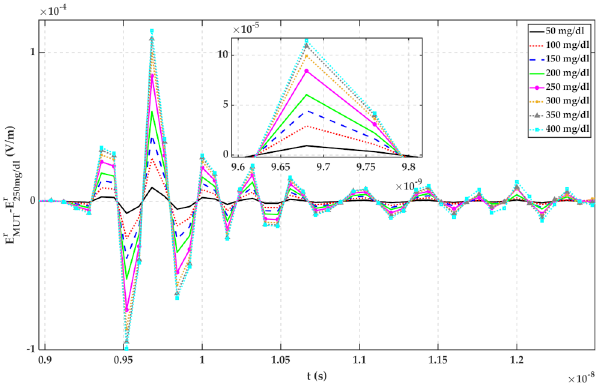
Figure 10. Reflected signal differences of various MUTs concerning water with 25 mg/dL glucose (measured with